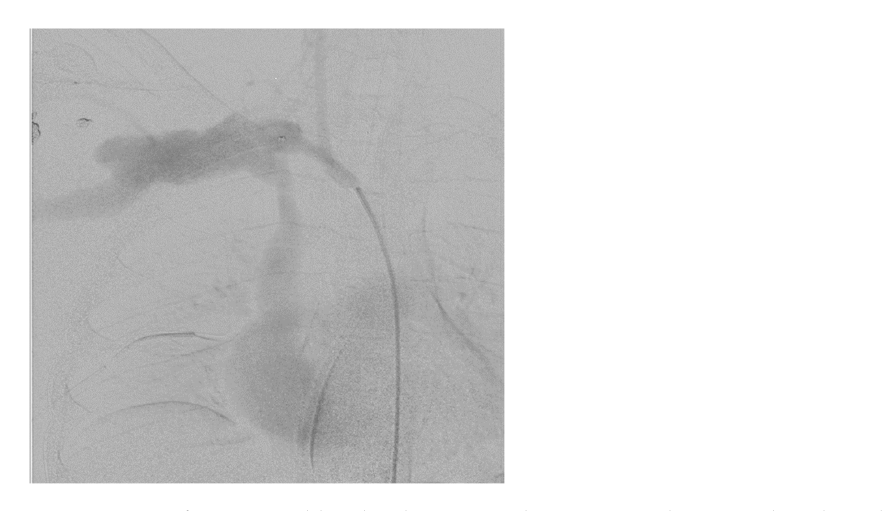
Figure 2. DSA of a 24 ‐ year ‐ old male who sustained a zone I gunshot wound on the right side. DSA showed injury of the distal part of the right subclavian artery, and the patient was subsequently managed via open repair using a prosthetic graft.